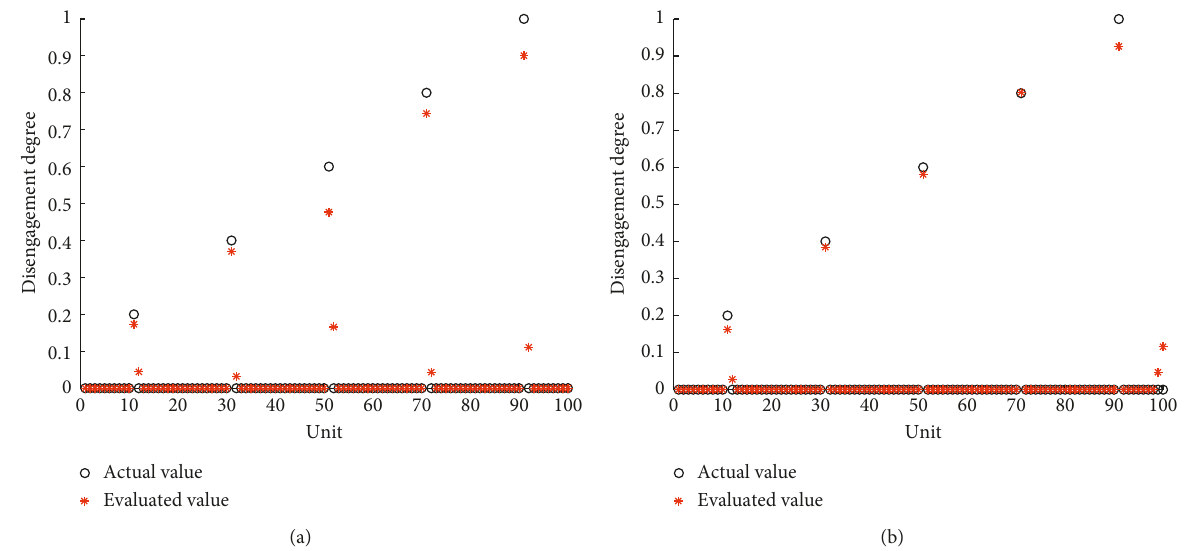
Figure 8: Estimation results of CMDEA under different vehicle speeds: (a) 250km/h; (b) 360km/h.